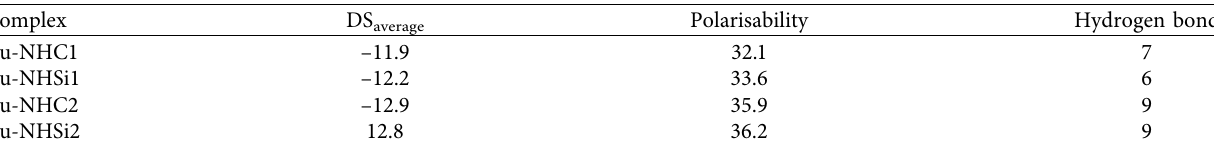
Table 6: Molecular docking parameters including the average docking score energy values, polarisability, and total hydrogen bonds of ligand-protein systems regarding both proteins 4G9M and